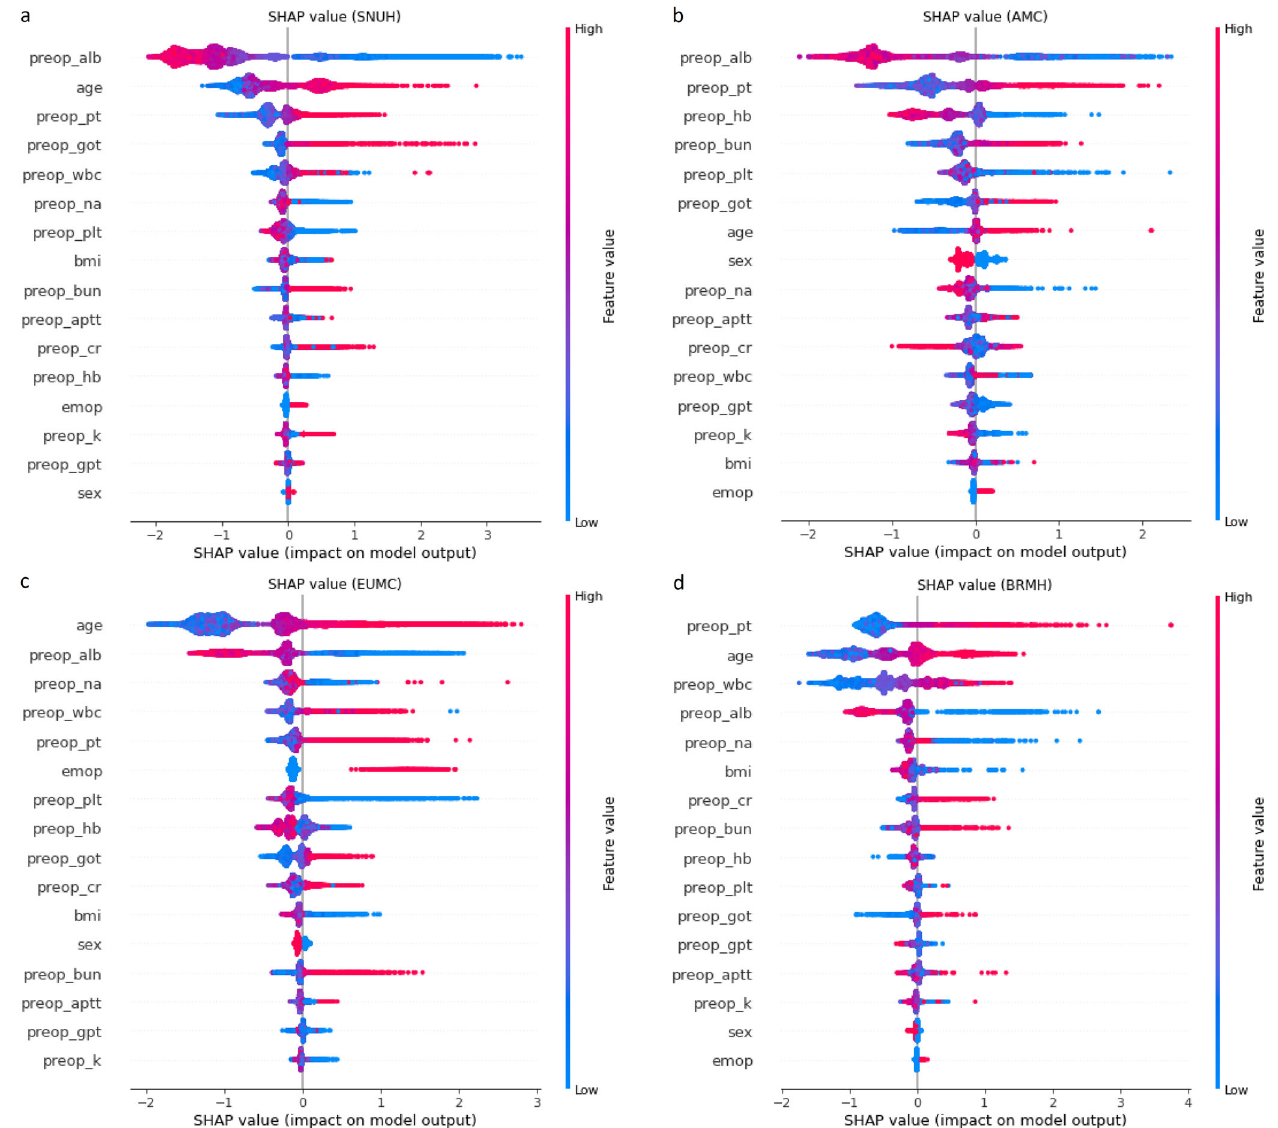
Fig. 2 Feature-importance of each hospital model with respect to SHAP value. a SNUH model, b AMC model, c EUMC model, d BRMH model. SHAP Shapley additive explanations, SNUH Seoul National University Hospital, AMC Asan Medical Center, EUMC Ewha